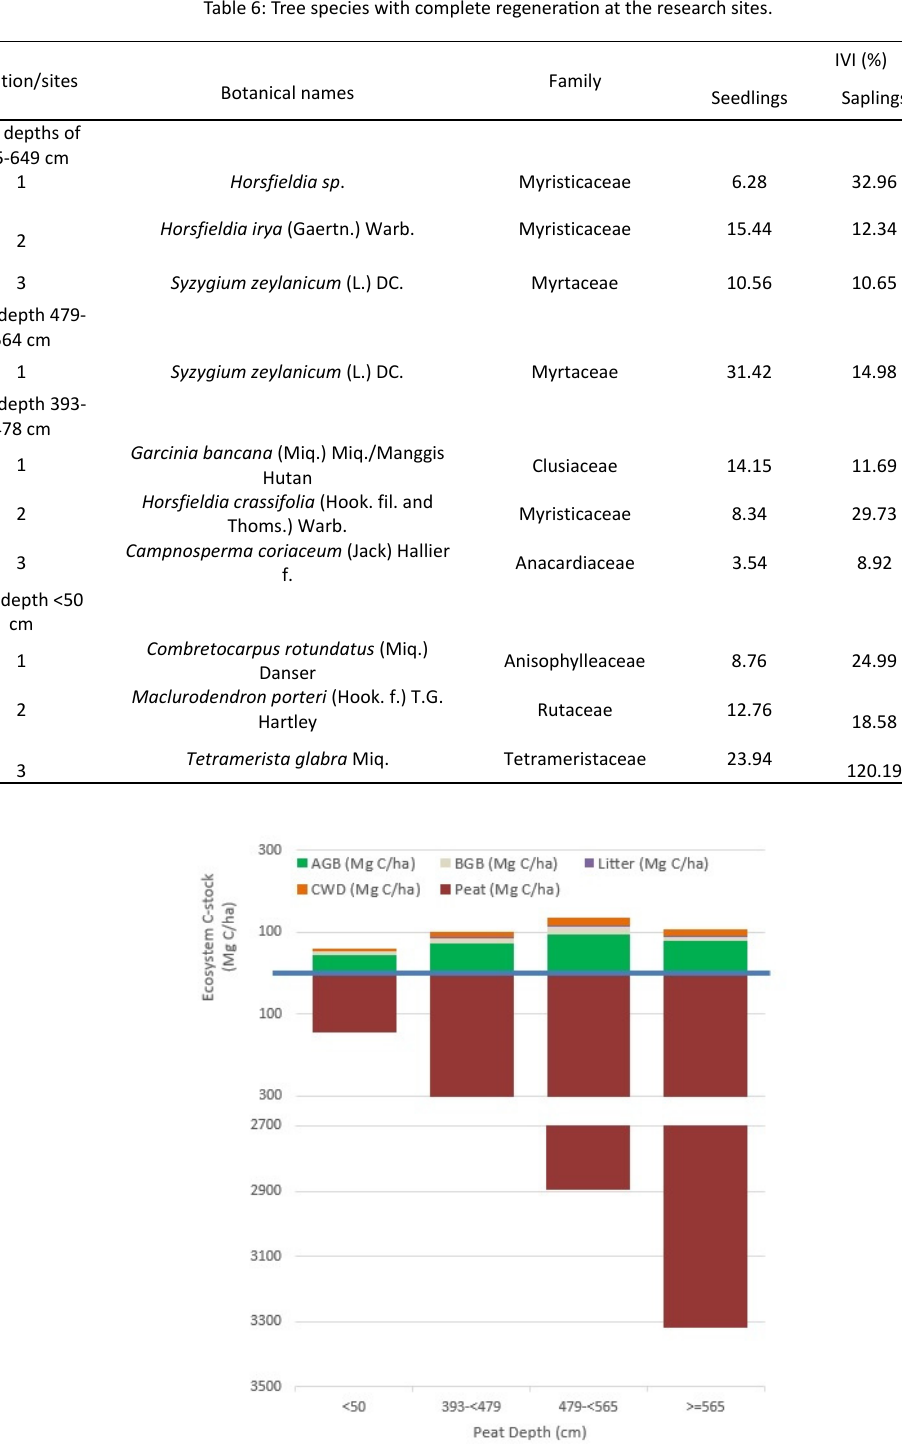
Table 6: Tree species with complete regeneration at the research sites.